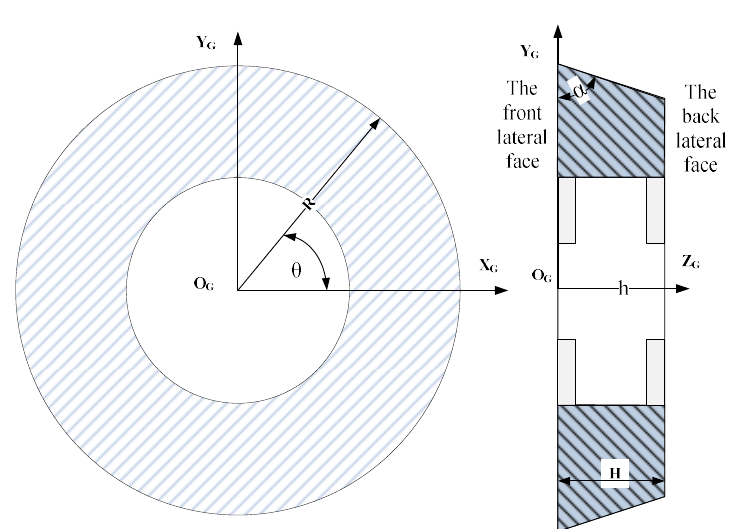
Figure 1. Modeling of conical grinding wheel.